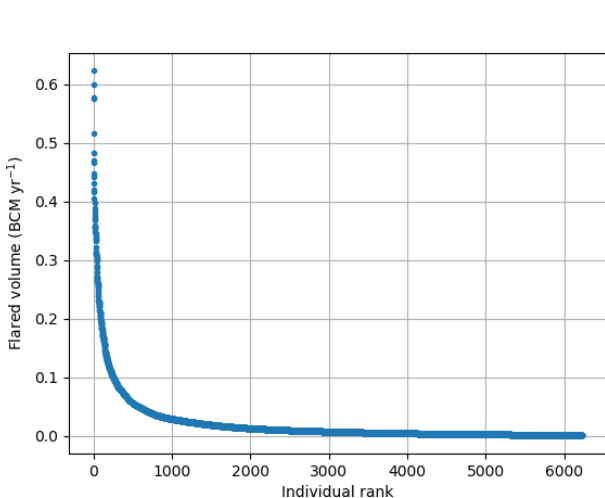
Figure 10. Average radiative power (MW) at the 6232 flaring locations.